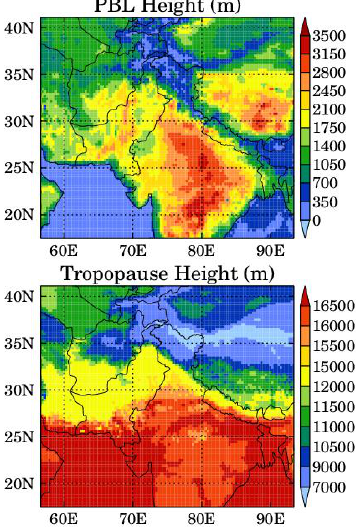
Fig. 3. Spatial distributions of WRF-Chem simulated daytime (09:30 to 16:30IST) average planetary boundary layer (PBL) and tropopause height over the model domain during 17–22 April 2010. Indian standard time (IST) is 5.5h ahead of UTC.